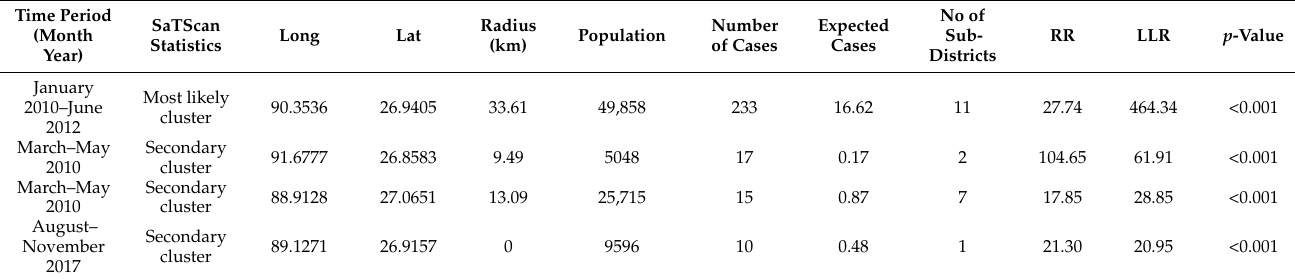
Table 5. Significant Plasmodium vivax space–time clusters at sub-district level in Bhutan,